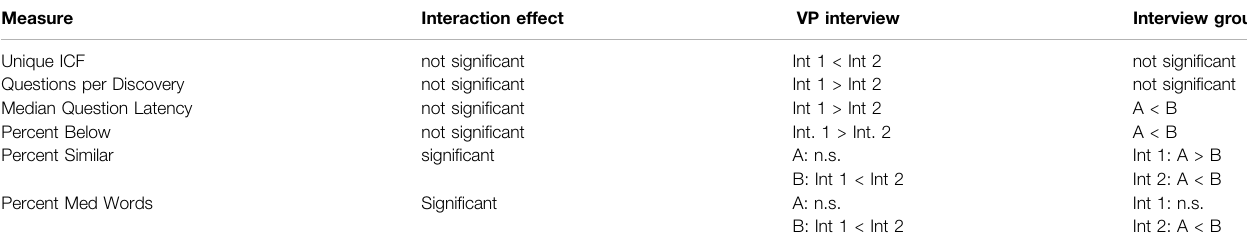
TABLE 3 | A summary of the ANOVA results (interaction and main effects) for the Message Production Trends study. Measure